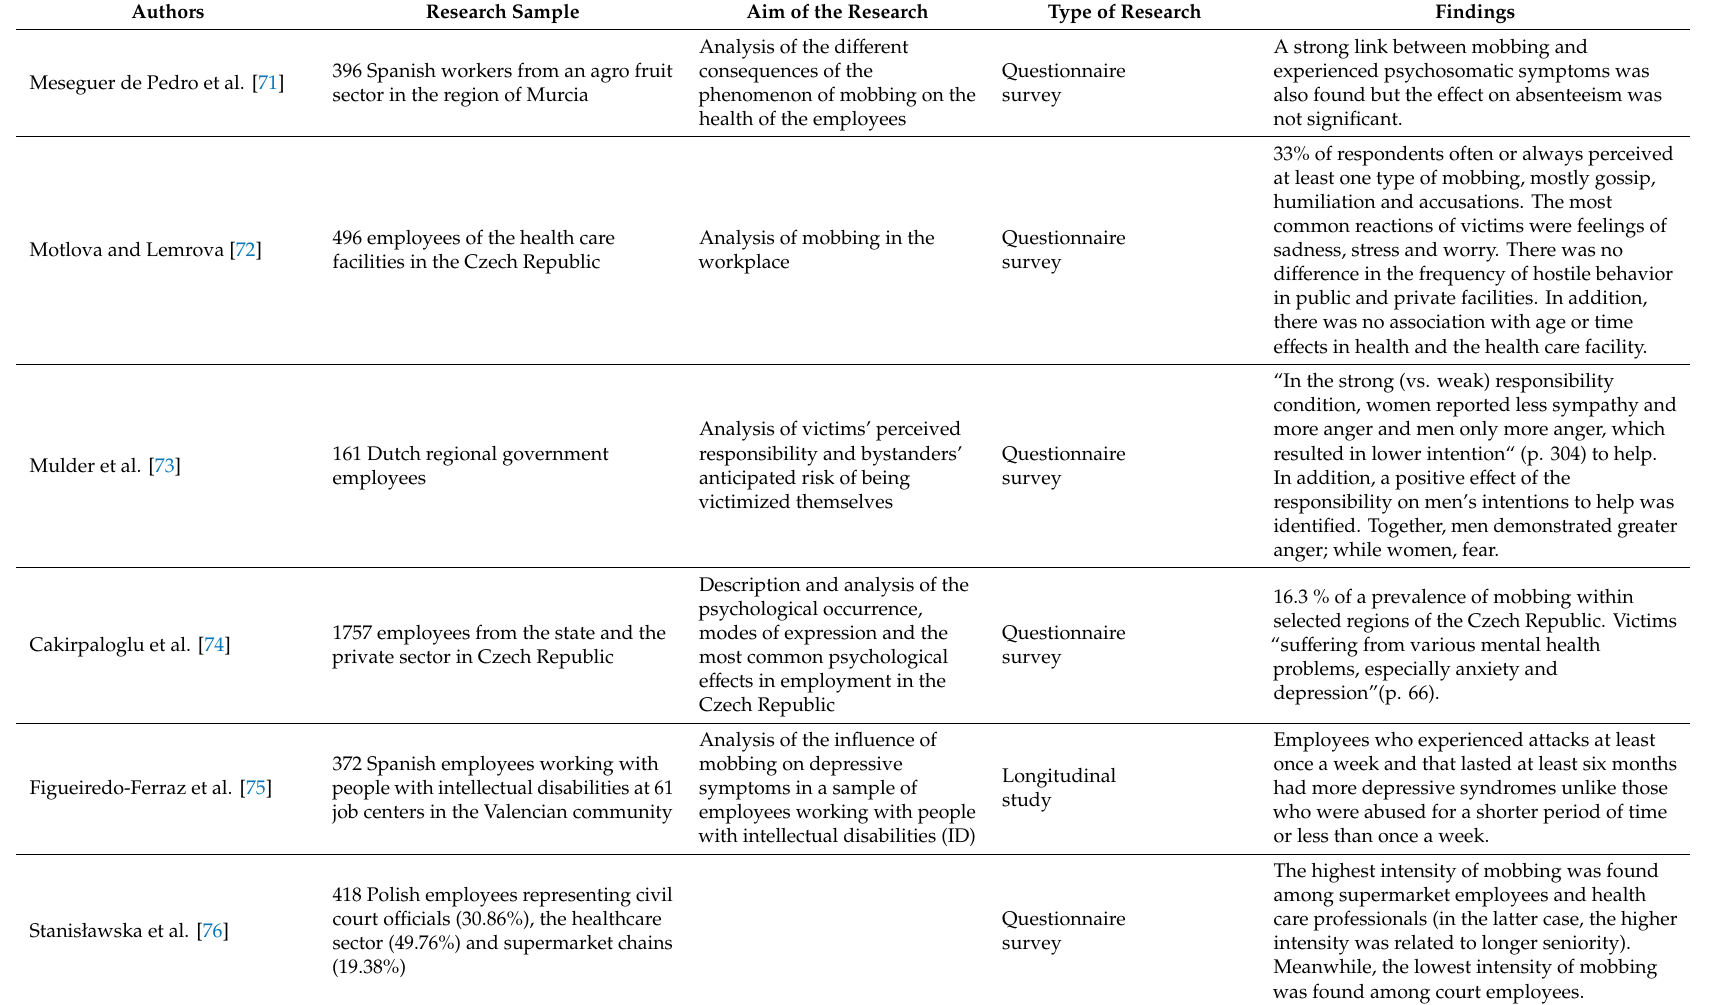
Table 1. Research on mobbing in developed countries—literature